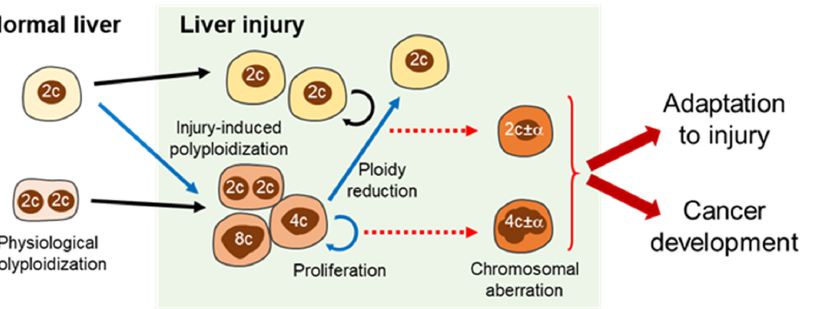
Figure 4. Significance of ploidy alterations in liver injuries and cancer development. Hepatocyte polyploidization is enhanced in injured livers. Both diploid and polyploid hepatocytes proliferate for regeneration in injured livers, and ploidy reduction is sometimes induced during regeneration driven by polyploid hepatocytes. These processes (blue arrows) are likely to be a source of chromosome aberrations in hepatocytes (red dashed arrows). Moreover, the chromosome aberrations enhance genetic variation in hepatocytes, increasing the chance of hepatocyte adaptation to liver injuries as well as liver cancer initiation. 2c, 4c, and 8c denote diploid, tetraploid, and octaploid DNA contents, respectively. 2c ± α and 4c ± α indicate aneuploidy.